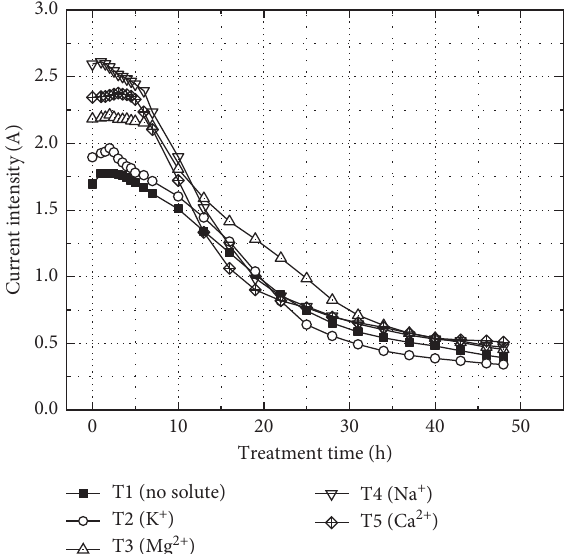
Figure 6: Current intensity variations over treatment time.